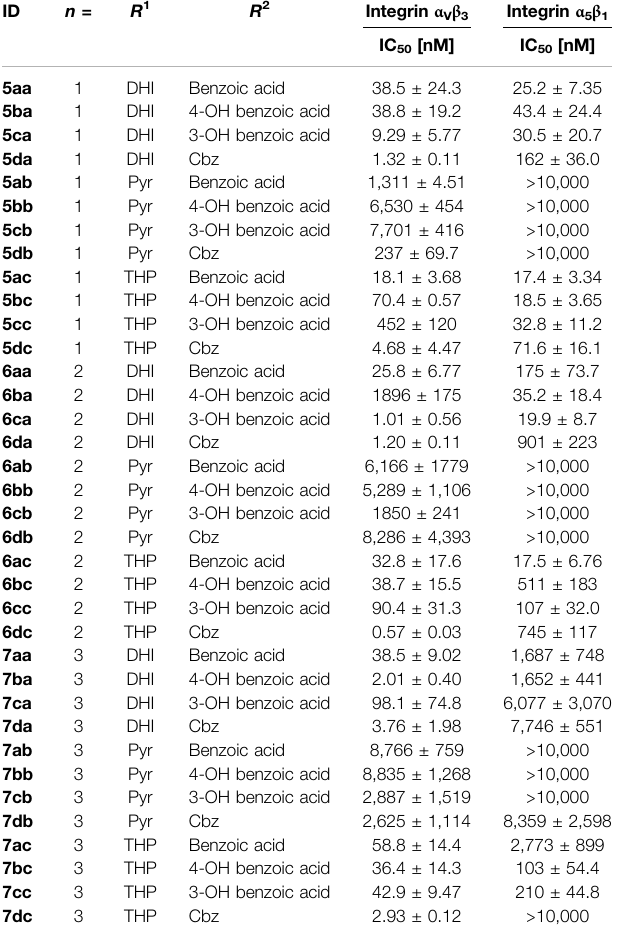
( Figure 8 ) con fi rms the assumption that a change to a pyrimidinyl group as R 1 in each structural environment leads to generally lower af fi nities and selectivity.